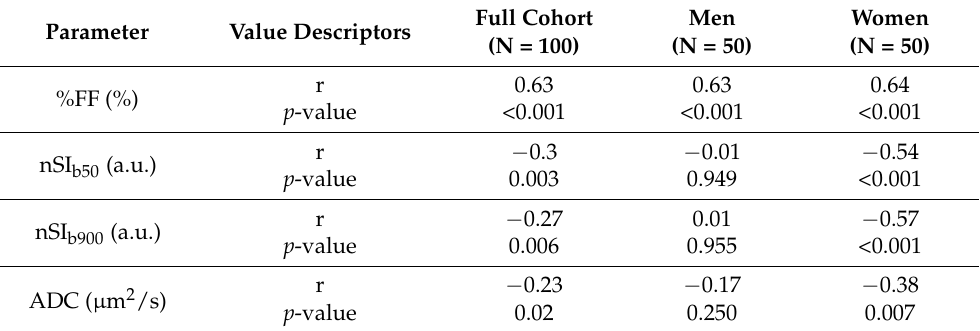
Table 4. Correlation with age of imaging-derived apparent diffusion coefficient, normalized diffusion weighted signal intensity and relative fat fraction values for bone marrow. Parameter Value